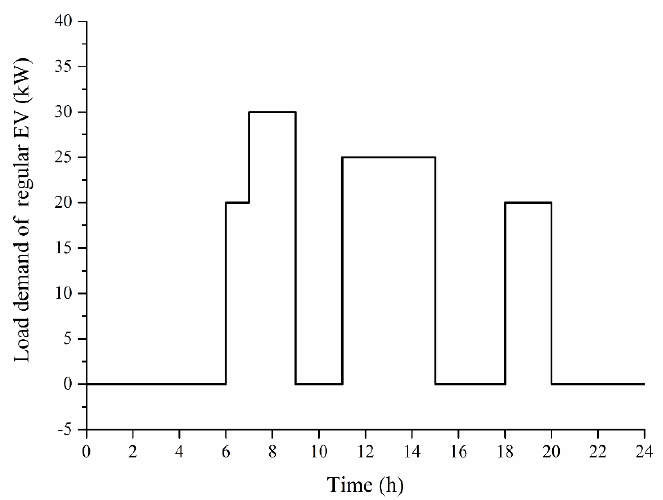
Figure 1. Daily load curve of a regular